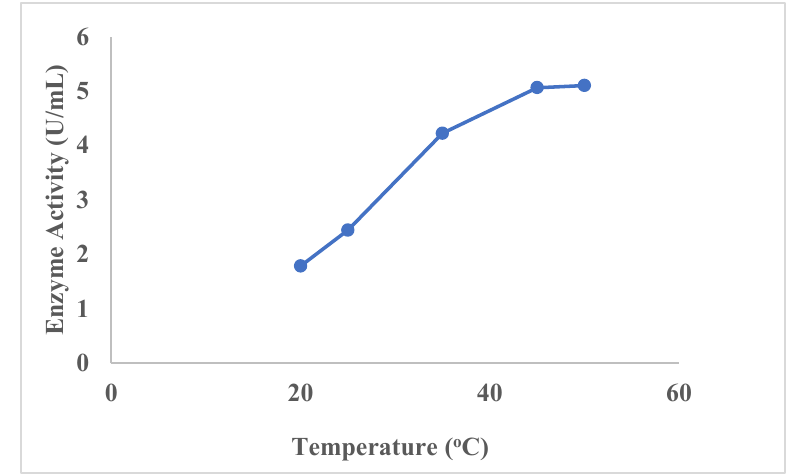
Figure 10. Enzyme activity (U/mL) at different temperatures. The optimal pH for maximum laccase activity was obtained at pH 5.5. It was also seen that above this pH, enzyme activity was observed to decline. Previous research revealed that pH 4.0–6.0 is usually considered a stable pH for fungal laccase. The alternation in pH depends on the fungal strain. T. trogii gave a high activity at pH 3.0, while Stereum gave stale laccase at pH 6.0 [56]. The pH characterization has been given in Figure 11.